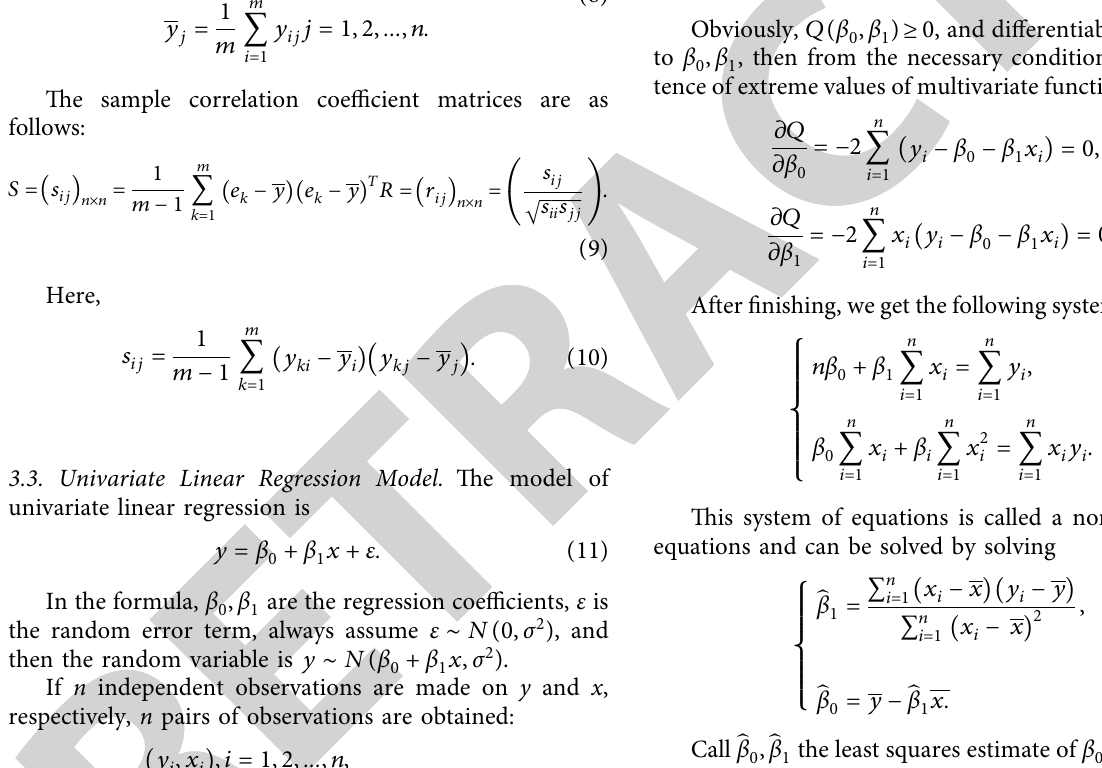
Figure 1: Schematic diagram of the basic principle of